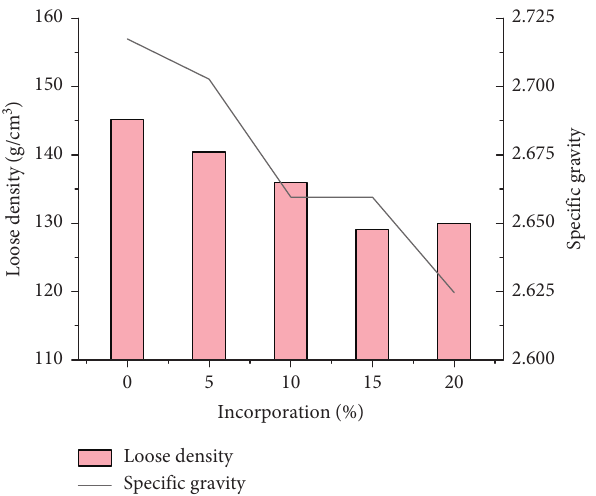
Figure 11: Loose density and specific gravity of red clay samples doped with different contents of calcium